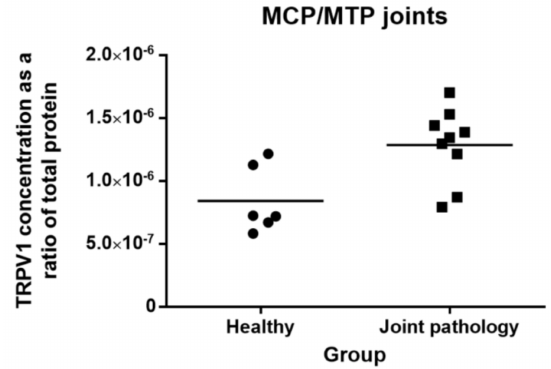
Figure4. Concentrationoftransientreceptorpotentialvanilloid1(TRPV1)proteininsynovialmembrane tissue from MCP / MTP joints (ng / mL) relative to total protein (ng / mL). Symbols indicate individual joints (circles = healthy; squares = joint pathology). The mean is indicated by the horizontal bar.